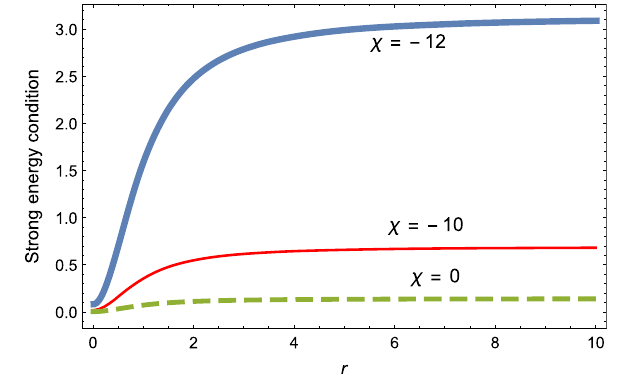
Fig. 5 Strong energy versus radial value r